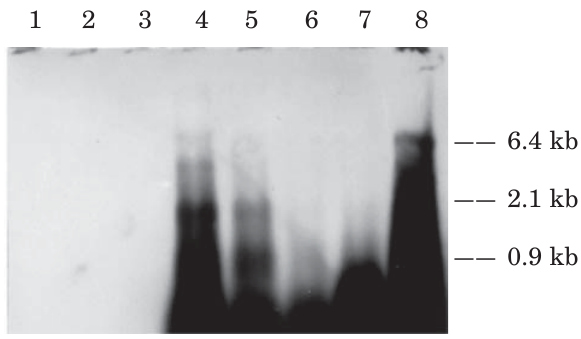
Fig. 3. Northern blot hybridization analysis of the accu- mulated PVX RNAs in the systemically infected upper leaf No. 5 of three tomato cultivars 7 days after single or mixed inoculation with PVX and ToMV-L. Lanes 1 and 2 are samples from mock-inoculated (healthy) and ToMV-L alone in cv. Fukuju No. 2 plants while lane 3 is ToMV-L alone in cv. GCR 236. Lanes 4, 5, and 6 are PVX+ToMV-L in cv. Fukuju No. 2, GCR 236, and GCR 237 respectively. Lane 7, PVX alone in GCR 237 and lane 8, 1 µg of purified PVX RNA used as a marker. PVX RNAs were hybridized with a cDNA probe prepared from a 350 nts portion in the coat protein gene of PVX and labeled with Digoxigenin (DIG). The hybrid- ized RNAs were immunodetected using anti DIG-alka- line phosphatase conjugate. The positions of the genomic (6.4 kb) and subgenomic RNAs (2.1 kb and 0.9 kb) de- termined from preliminary experiments and from stand- ard texts are as